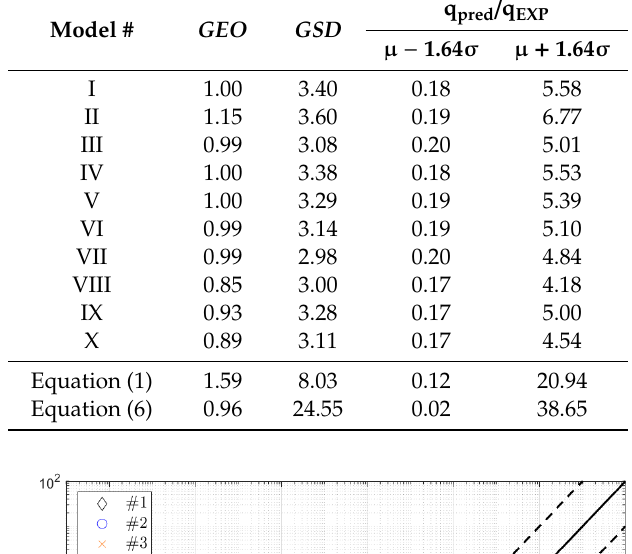
Table 3. Geometric mean and standard deviation for each EPR model expression. The 90% interval of q predicted / q estimated is reported. GEO : geometric mean, GSD : geometric standard deviation.